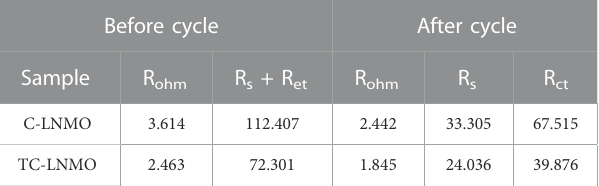
TABLE 2 Resistance parameters of LNMO samples before and after charging and discharging. Before cycle After cycle